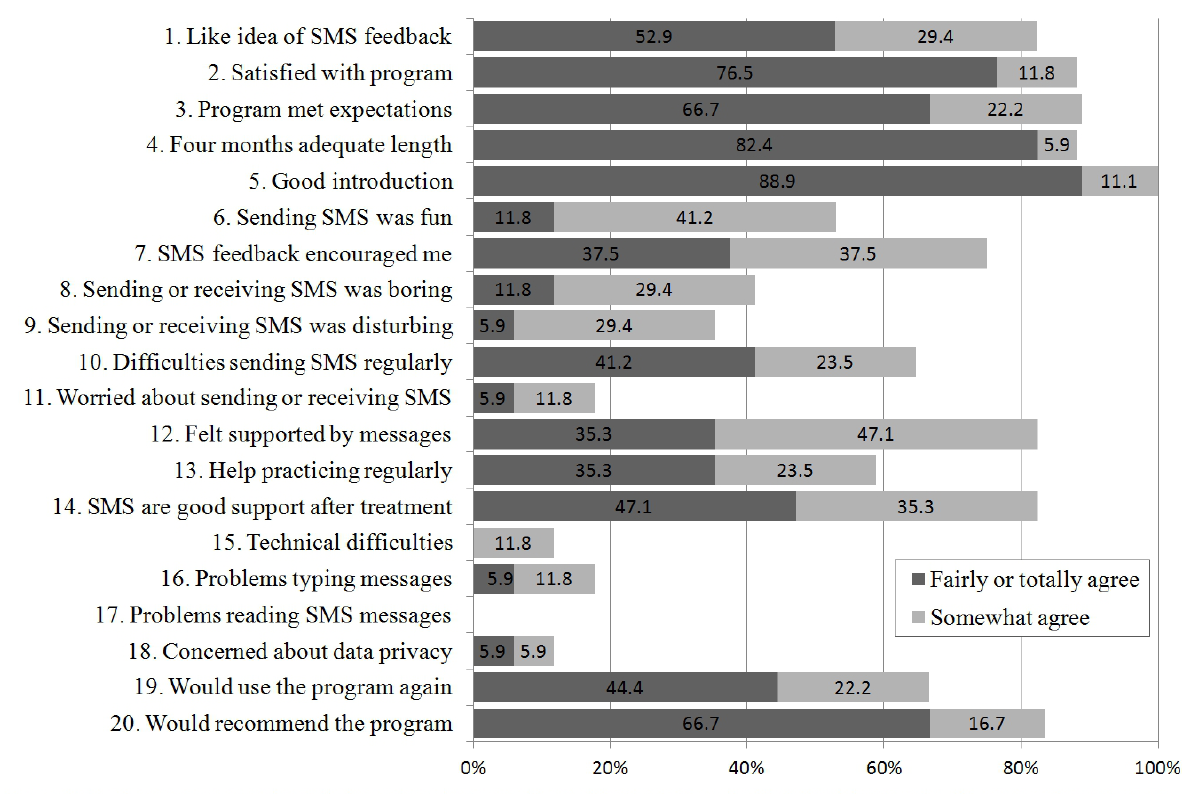
Figure 2. Satisfaction with the text message